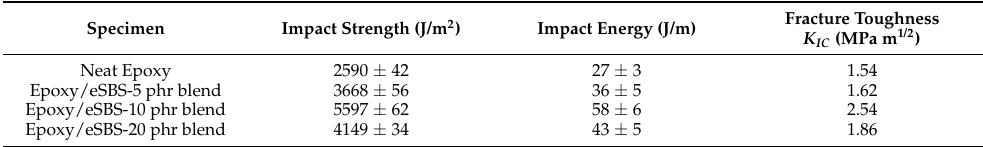
Table 1. Impact strength and impact energy values of neat epoxy and epoxy/eSBS blends.